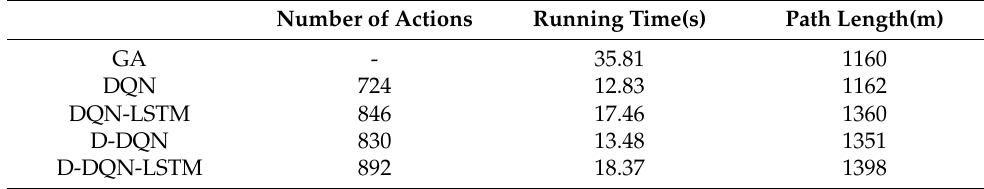
Table 4. Performance comparison of five algorithms in a static